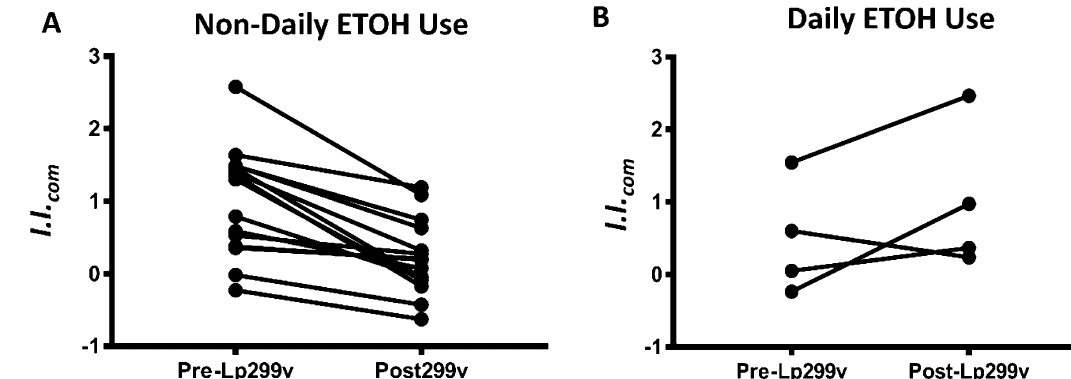
Figure 3. Impact of Lp299v supplementation on the Composite Inflammatory Index ( I.I. com ) for Non-Daily and Daily Alcohol Drinkers. (A) Exposure to post -Lp299v supplementation plasma from non-daily alcohol using subjects drove an anti-inflammatory gene expression profile in PBMCs compared to plasma obtained prior to Lp299v supplementations (0.22 ± 0.51 vs 1.01 ± 0.74, n = 15; P < 0.0001 by paired t-test). ( B ) Lp299v had no significant impact on the inflammatory gene transcription expression in subjects who reported drinking alcohol daily (0.49 ± 0.78 vs 1.01 ± 1.02, n = 4; P = 0.23 by paired t-test). All values given as mean ± SD.